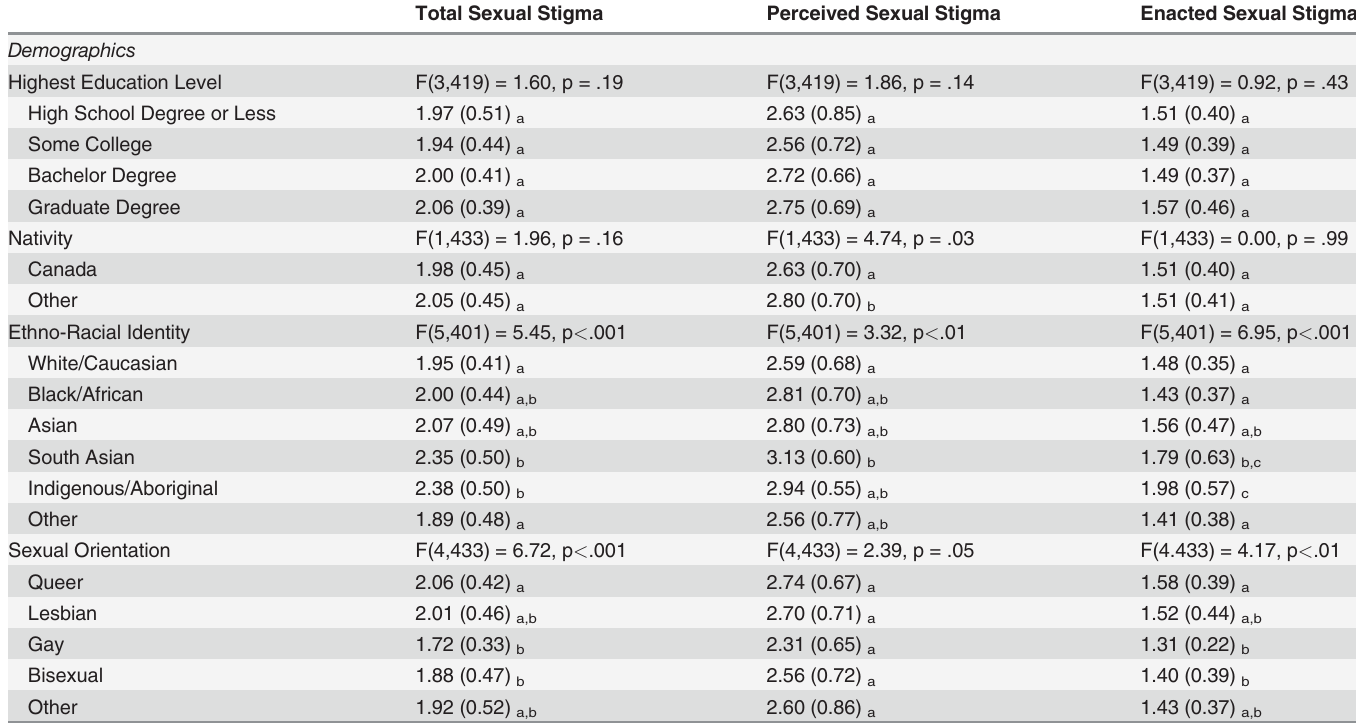
Table 4. Characteristics associated with total sexual stigma, perceived sexual stigma and enacted sexual stigma mean differences, with higher scores indicating higher sexual stigma (Study 1, phase 2 survey sample: n =